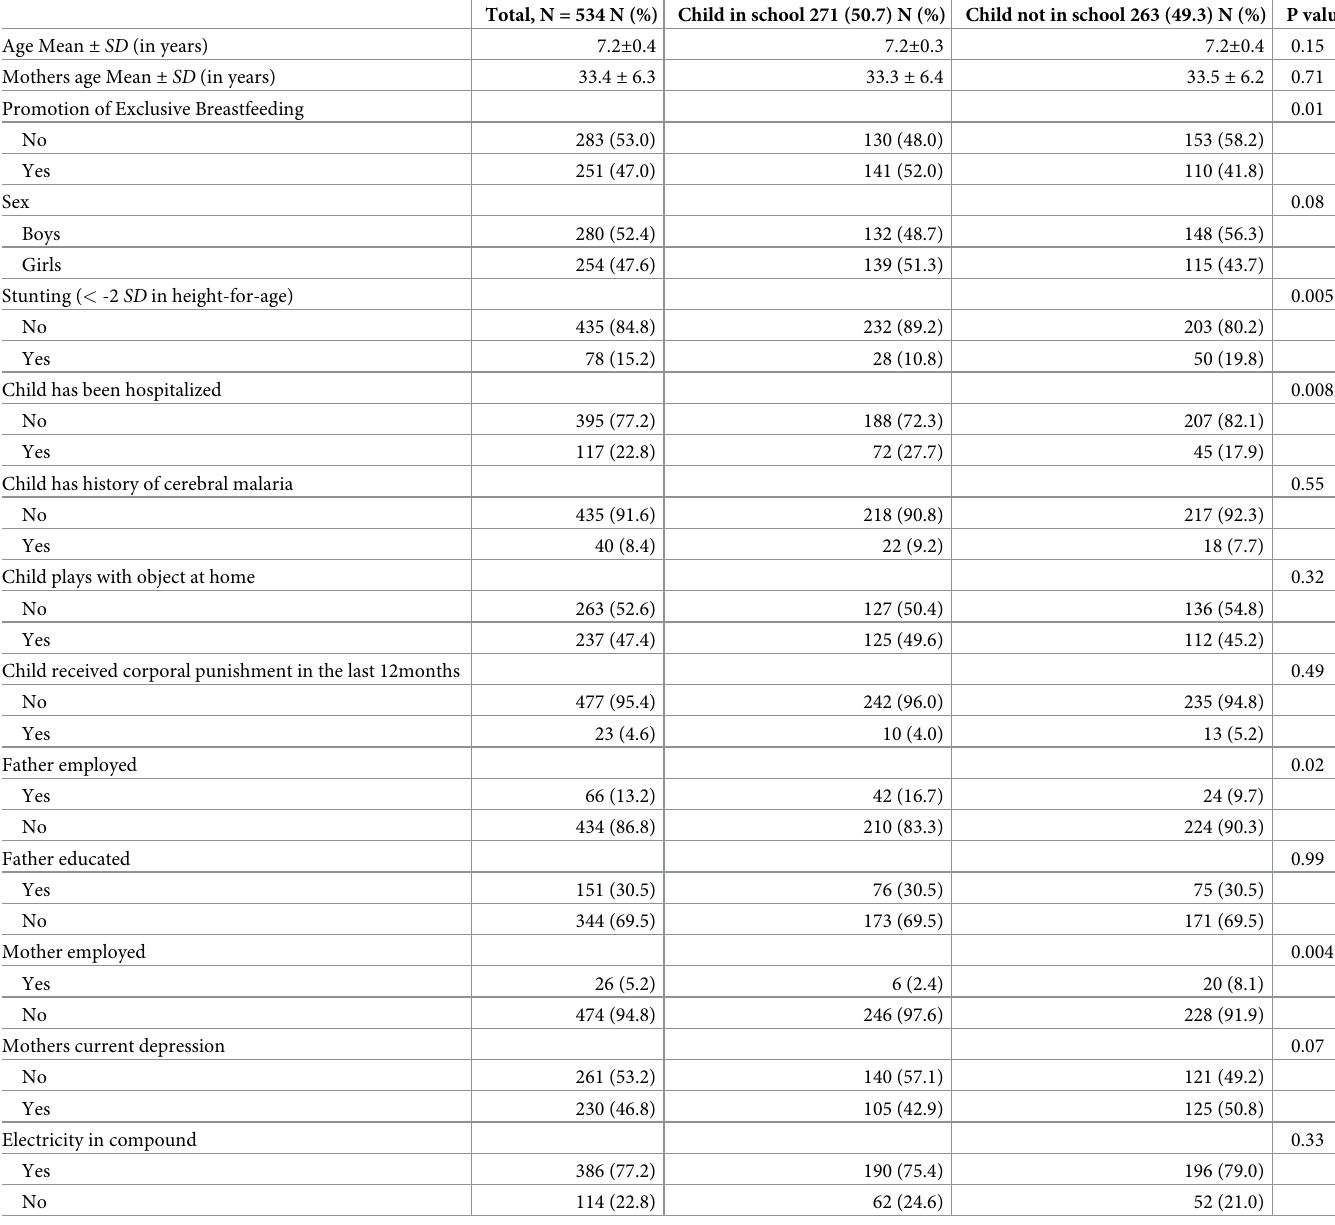
Table 2. Description of the children who completed the TOVA from the PROMISE Saving Brains study in rural Burkina Faso. Total, N = 534 N (%) Child in school 271 (50.7) N (%) Child not in school 263 (49.3) N (%) P